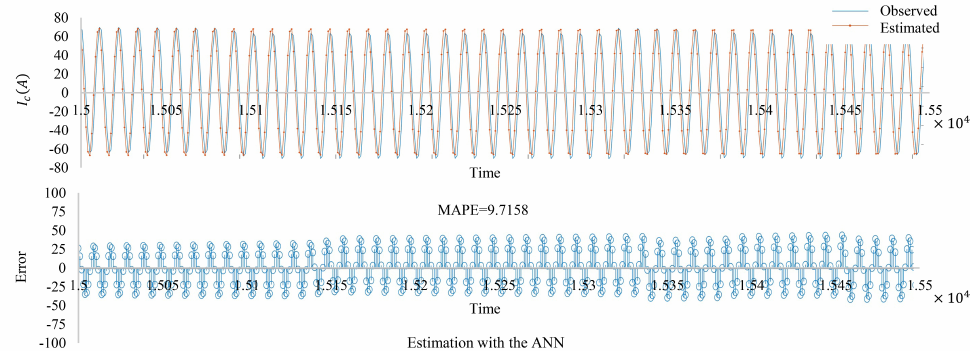
Figure 12. I c when the line-to-line fault occurs in I b and I c for the